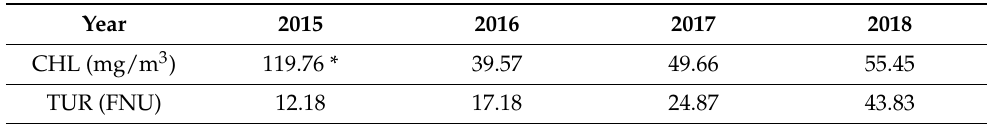
Table 4. Mean CHL and TUR concentrations throughout the years (* only one image was available for this